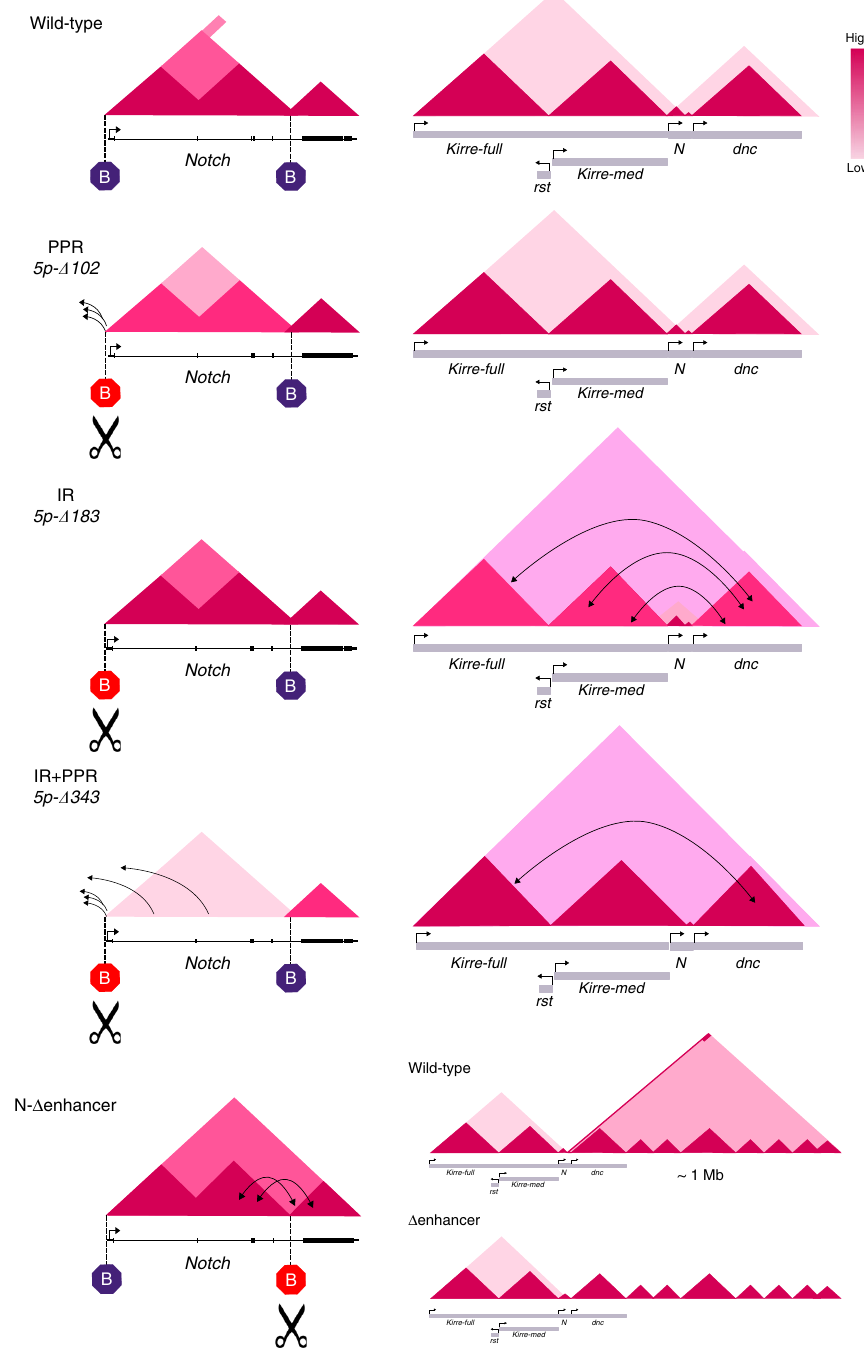
Fig. 6 Domain boundaries actively partition the Notch gene locus into TADs and mediate the formation of a megabase-sized domain. The Notch gene locus is organized into two TADs with boundaries overlapping the 5 ′ intergenic region of Notch and an intronic enhancer. Deletion of the Promoter Proximal Region (PPR) results in loss of intra-domain interactions at the D1 domain of Notch and is accompanied by ectopic interactions of the 5 ′ UTR with the upstream TAD. Deletion of the Intergenic Region just upstream of the PPR (IR) leads to a major gain of ectopic interactions between the TADs fl anking Notch . Deletion of the full intergenic region of Notch (IR + PPR) results in TAD fusion and gain of ectopic interactions between TADs fl anking Notch . Deletion of the intragenic enhancer results in fusion of Notch domains and loss of a megabase-sized domain downstream of No 6-well plate. After 3 days (9 days post-transfection) an aliquot of cells was used for (Promega) was used for transfection using manufacturer guidelines (https:// DNA extraction by phenol-chloroform and PCR genotypi fi cation using speci fi c worldwide.promega.com/techserv/tools/FugeneHdTool/). A 4:2 FugeneHD: primers spanning the desired deletions (see Supplementary Table 2). Pools of Plasmid ratio was used for all transfections. Transfected cells were placed at 25 °C mutant cells were expanded in fresh Schneider ’ s Drosophila Medium without and 72h after transfection cells were re-suspended in fresh medium supplemented Puromycin and used for serial dilution and isolation of clones of mutant cells. with 5 μ g/mL of Puromycin (Sigma) and transferred into a well of a 12-well plate. Clonal isolation of mutant cells . Pools of mutant cells were used for serial After 3 days (6 days post-transfection), cells were re-suspended in fresh medium dilution as described in with minor modi fi cations 56 . Mutant cells were re- supplemented with 5 μ g/mL of Puromycin (Sigma) and transferred into a well of a